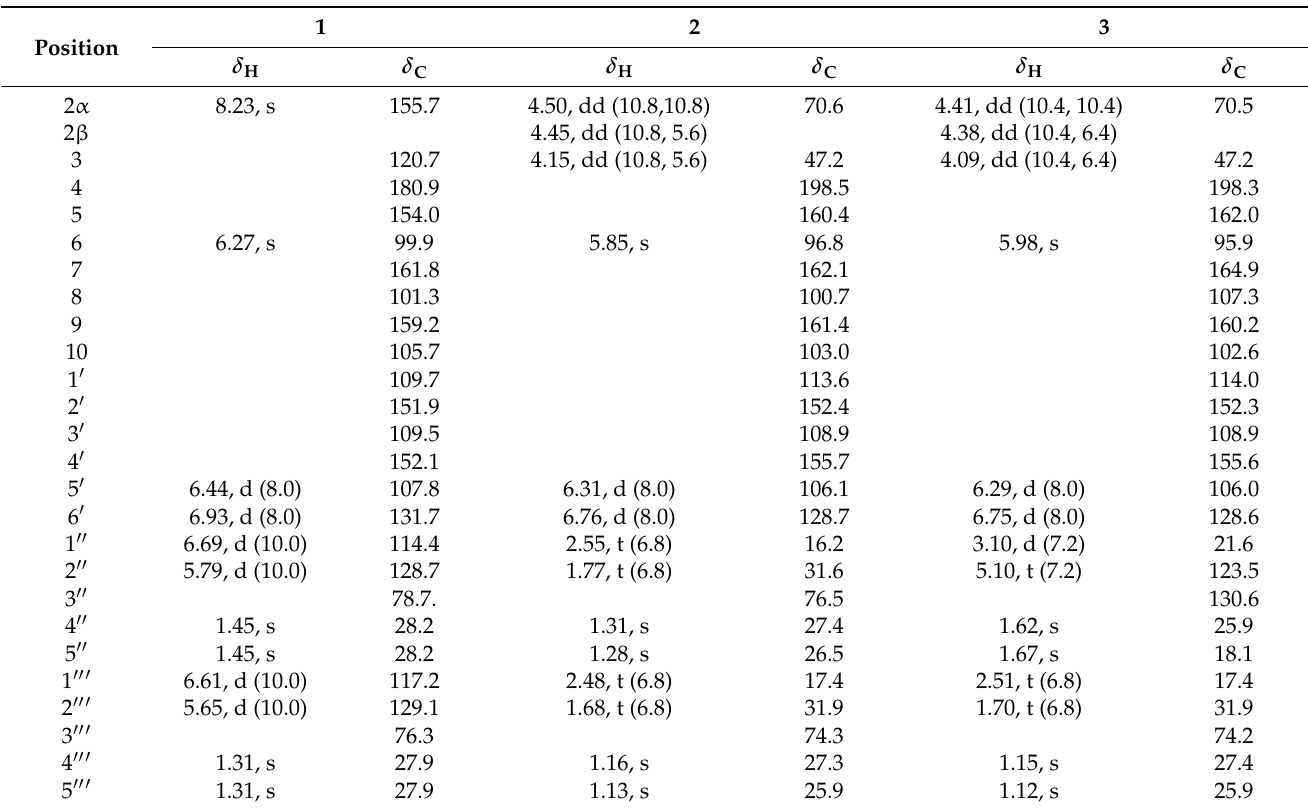
Table 1. NMR spectroscopic data for compounds 1 – 3 in DMSO- d 6 ( δ values in ppm, J values in